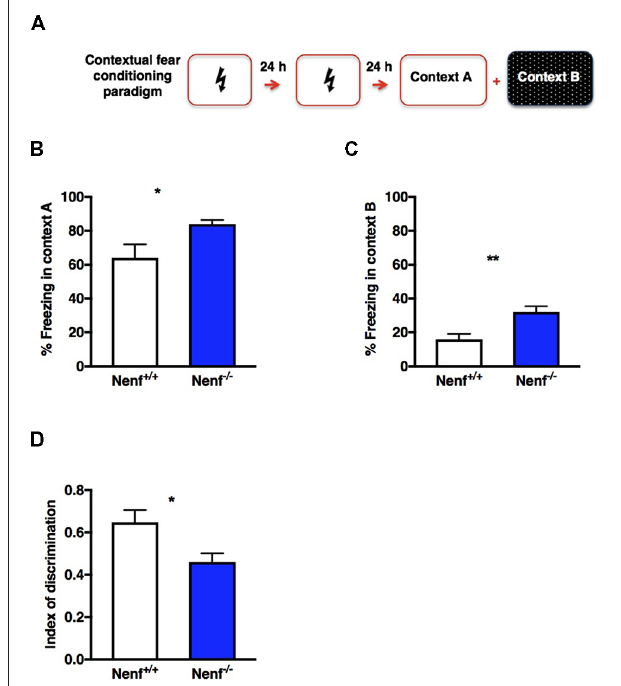
FIGURE 4 | Hippocampal dependent memory impaired in the absence of NENF. An experience-dependent contextual fear conditioning (CFC) discrimination paradigm was performed (A) . NENF − / − mice showed more freezing in the aversive context (context A) compared to controls (B) this difference is also present in the novel context (context B; C) . A decrease index of discrimination between aversive and novel contexts is observed in NENF − / − when compared to Nenf + / + (D) . Data presented as Mean ± SEM analyzed by two-tailed Student’s t -test ∗ p < 0.05 and ∗∗ p <